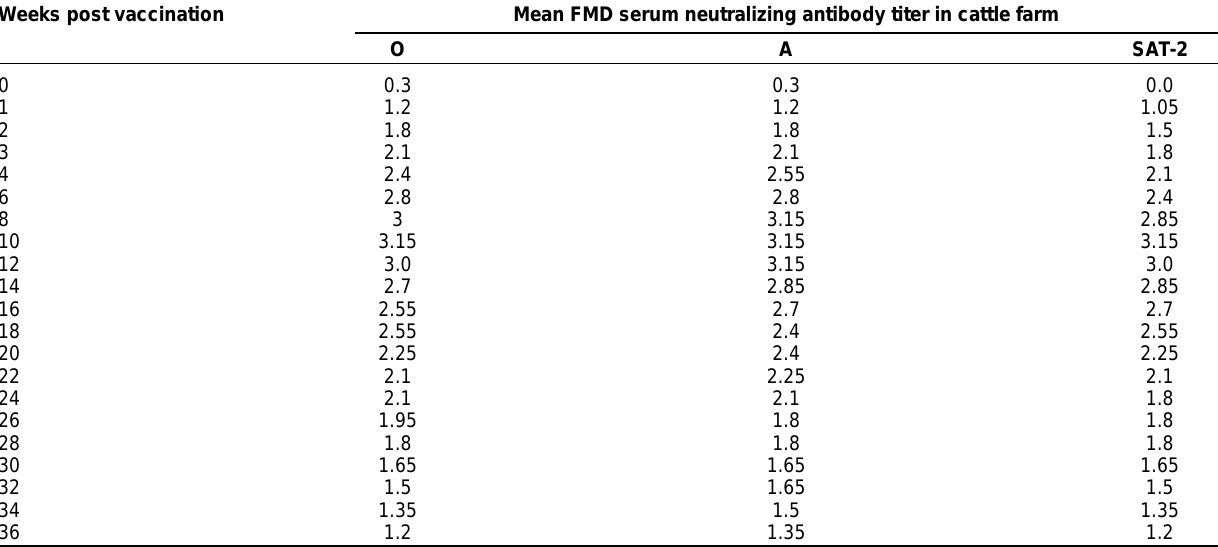
Table-8. Mean FMD serum neutralizing antibody titters in cattle vaccinated with trivalent FMD inactivated ISA 206 oil vaccine Weeks post